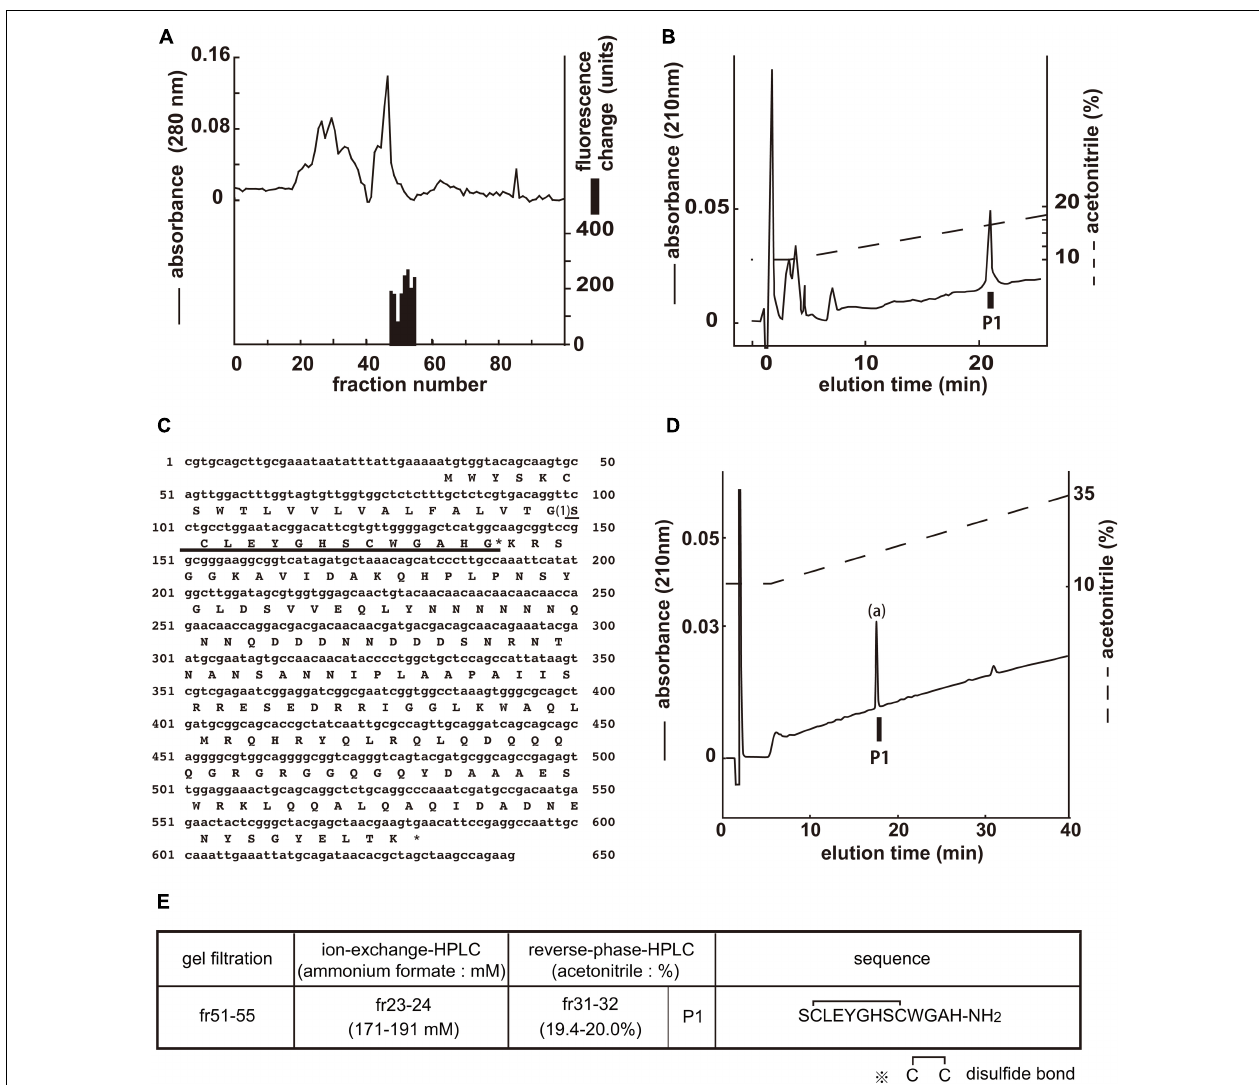
CCHamide-1 sequence is underlined as (1). (D) Chromatographic comparison by RP-HPLC of natural CCHamide-1 and synthetic CCHamide-1. Black bar (P1) indicates the changes of [Ca 2 + ] i fluorescence signal in CHO-CG30106 cells. Each peptide was applied to a Symmetry C18 column (3.9 mm × 150